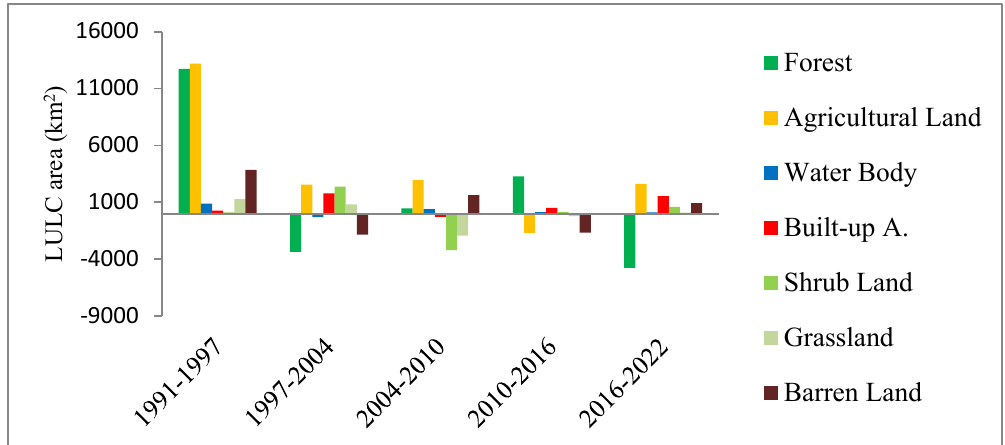
Figure 7. Gain and loss of LULC (1991–2022) .